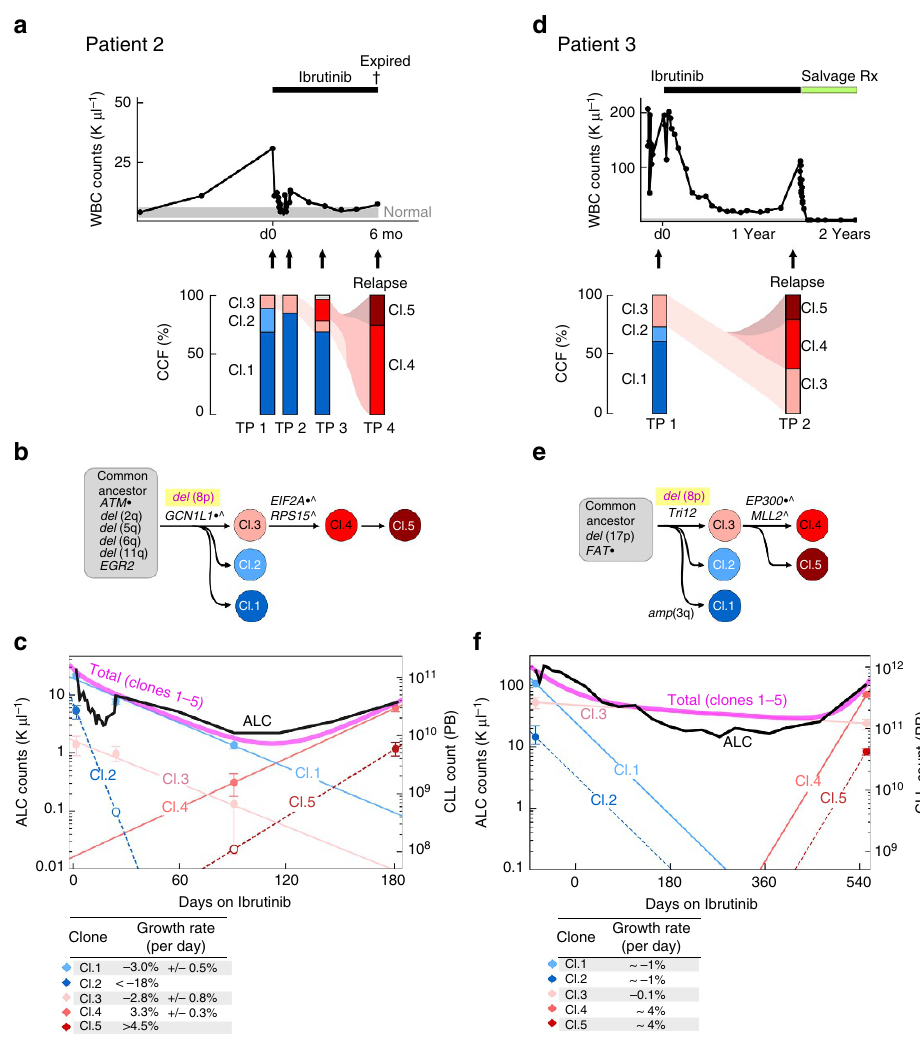
Figure 2 | Clonal evolution with early disease progression following ibrutinib. White blood cell counts and treatment courses of Patients 2 ( a ) and 3 ( d ). Peripheral blood specimens were sampled at serial time points (indicated by arrows), and CLL cells underwent whole-exome sequencing. Following somatic mutation calling, CCFs of somatic variants were inferred by ABSOLUTE analysis (Supplementary Figs 1 and 2). The phylogenetic trees for Patients 2 ( b ) and 3 ( e ) were inferred based on Phylogic. Driver mutations associated with each clone are indicated (a complete list of somatic mutations and allelic fractions found for each clone in Supplementary Table 2 and Supplementary Figs 1 and 2). Clonal kinetics during ibrutinib treatment for Patients 2 ( c ) and 3 ( f ). Filled circles—measurements combining clonal fractions and ALC counts. Empty circles are upper bound estimates (1% of total CLL cells) for clones that were below detection. Solid lines denote predicted kinetics for clones with at least two measurements. For Patient 2, dashed lines represent kinetics with minimal absolute growth rates for clones with only one measurement, while for Patient 3 the dashed lines represent kinetics obtained from fitting to ALCs. Measurements are shown with 95% CI obtained from posterior distributions of CCFs. For Patient 3, we assumed clones 1 and 2 have the same rates of decline and clones 4 and 5 have the same growth rates during